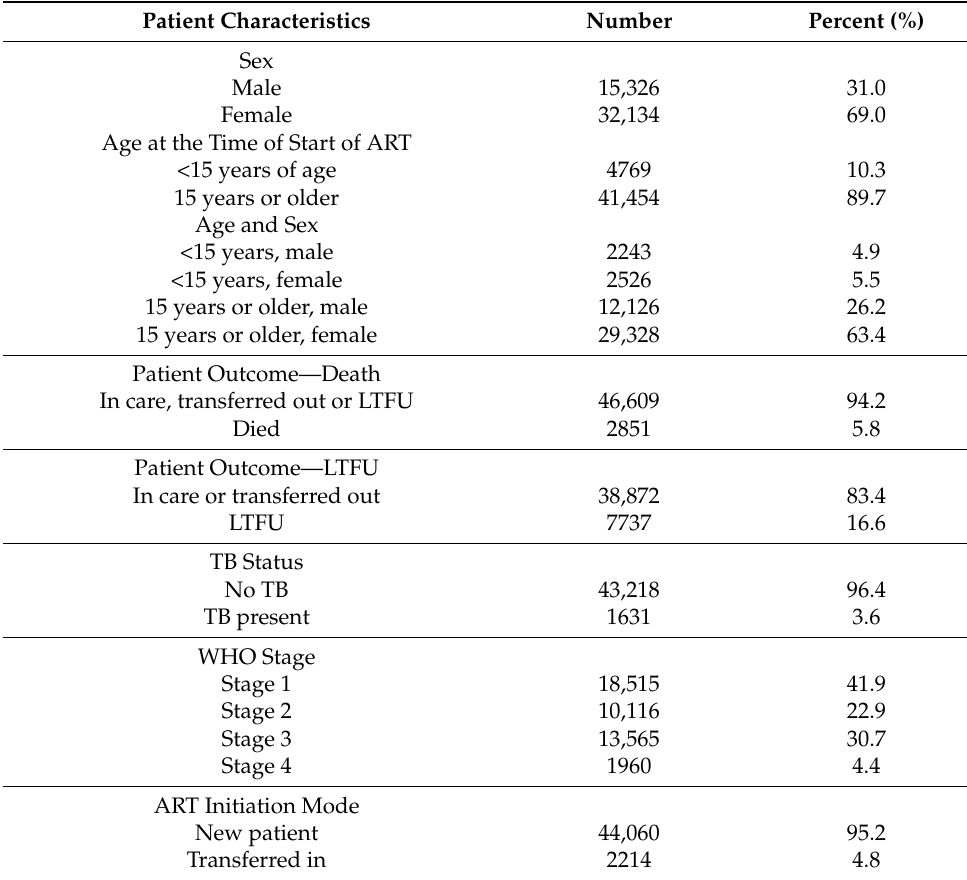
Table 1. Descriptive statistics for characteristics of patients in HIV/AIDS clinics of Haut-Katanga and Kinshasa provinces, DRC,